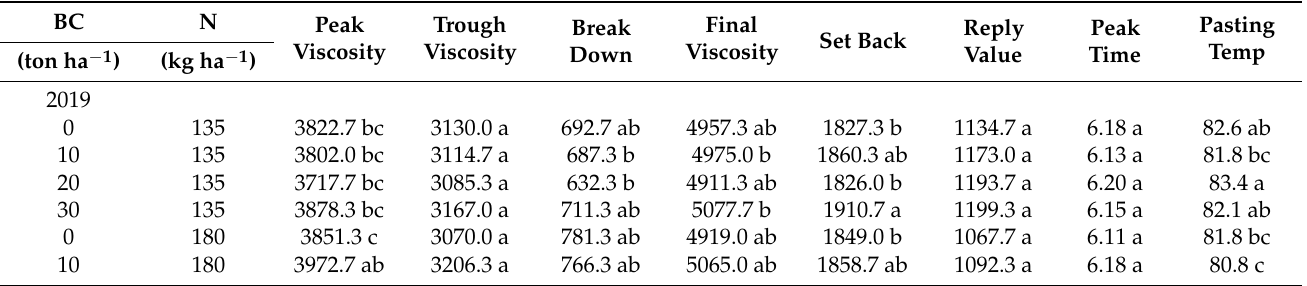
Table 1. Impacts of biochar and nitrogen fertilizer on Rapid visco-analyzer (RVA) profile characteris- tics of